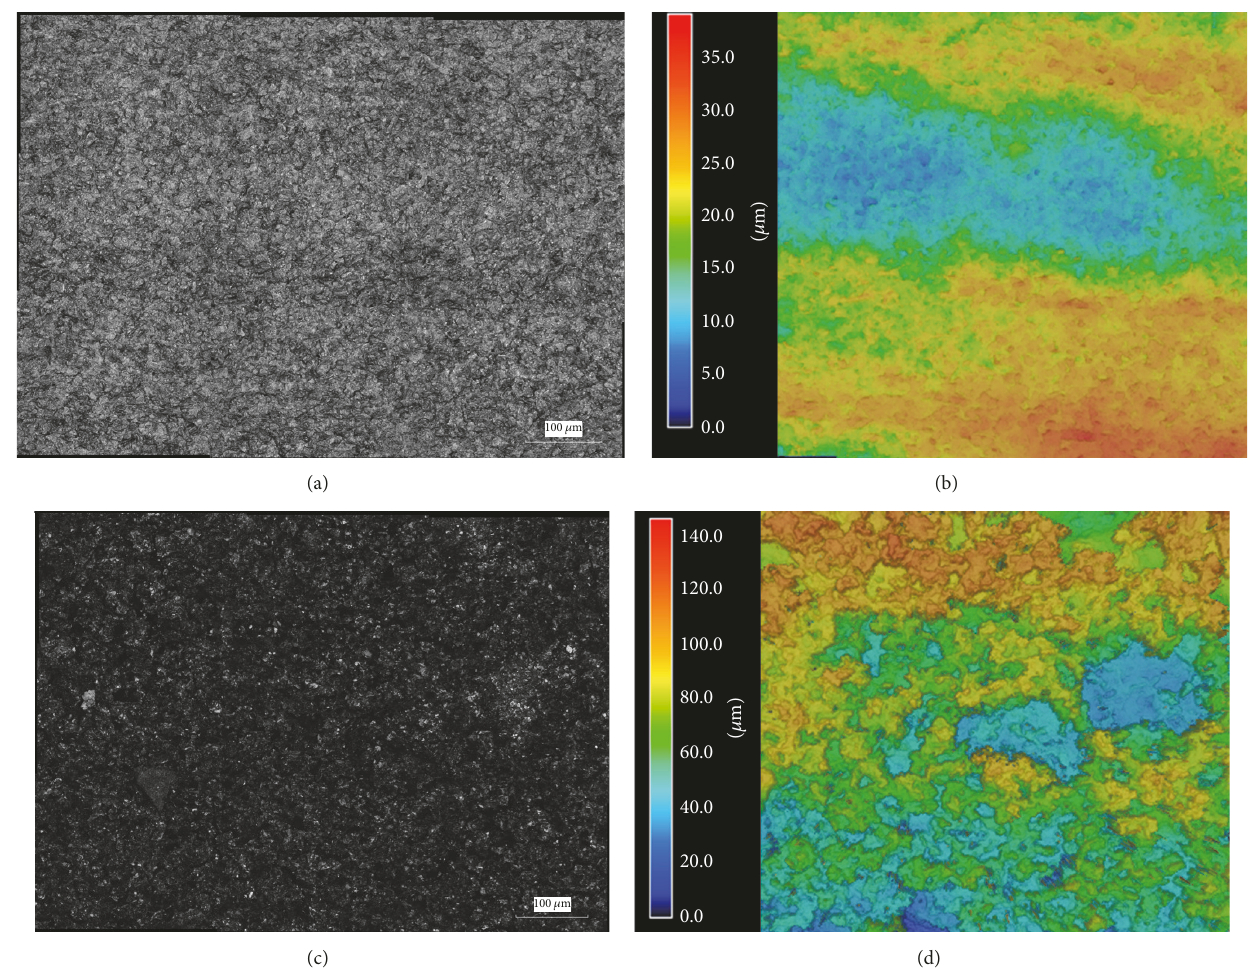
Figure 5: (a, b) Laser microscope and 3D topography images of oven-cured C1 and (c, d) photonic-cured